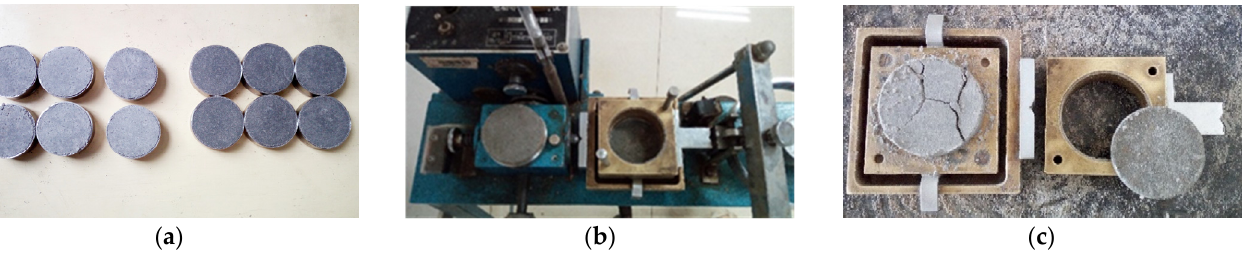
Figure 4. Direct shear test. ( a ) Direct shear specimens. ( b ) Direct shearing apparatus. ( c ) Specimens’ failure state.